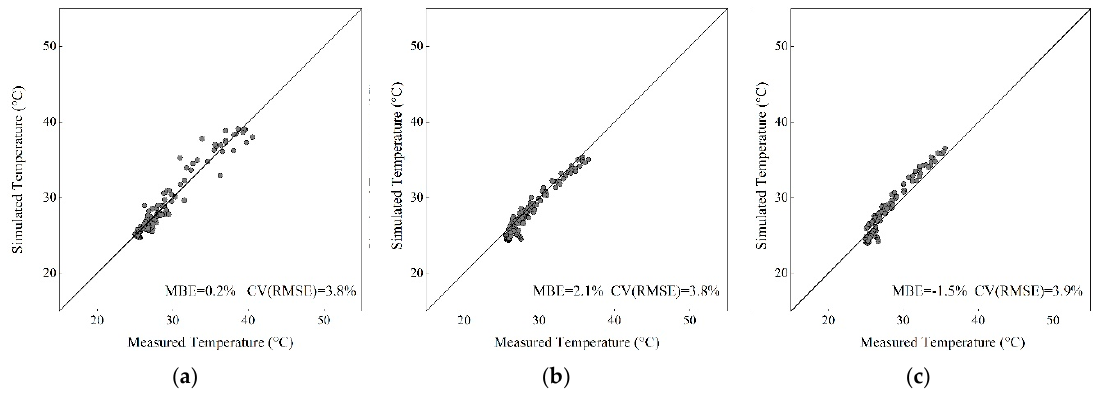
Figure 8. Comparisons of the simulated and measured values during the first measurement stage. ( a ) External surface temperatures of the green roof substrate; ( b ) internal surface temperatures of the green roof; ( c ) indoor air temperatures under the green roof.